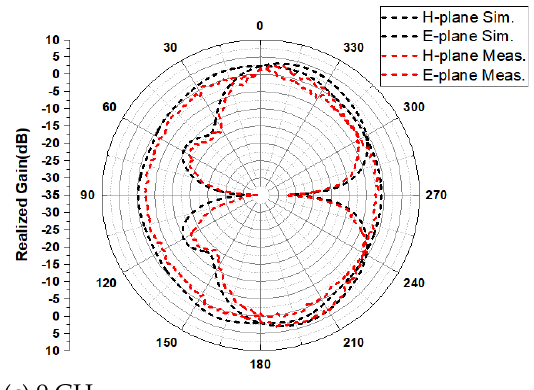
Figure 12. Simulated and measured radiation patterns for the E-plane and H-plane, respectively. ( a ) 2.42 GHz, ( b ) 5.72 GHz, and ( c ) 9 GHz.